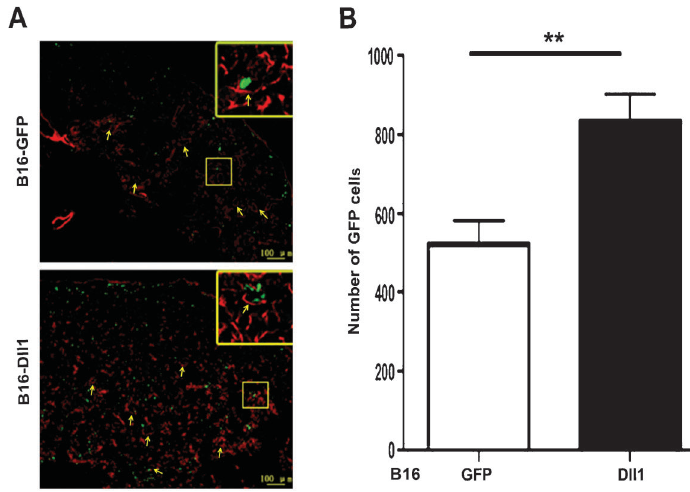
Figure 3. Overexpression of Dll1 led to tumor cell arrest in lung. A , Vessels of mouse lung were labeled with Evans blue (red) and sectioned, arrested GFP-labeled tumor cells (green) were detected with fluorescent microscope, at 40 6 magnification. Insets were amplified by laser scanning microscope at 200 6 magnification. Arrows indicate the vessels of mouse lung section. B , Average numbers of GFP-labeled tumor cells were counted in lung sections with the Image-Pro Plus Phase 6 Imaging System and compared. Data are reported as means±SD. **P , 0.01, unpaired Student t -test,